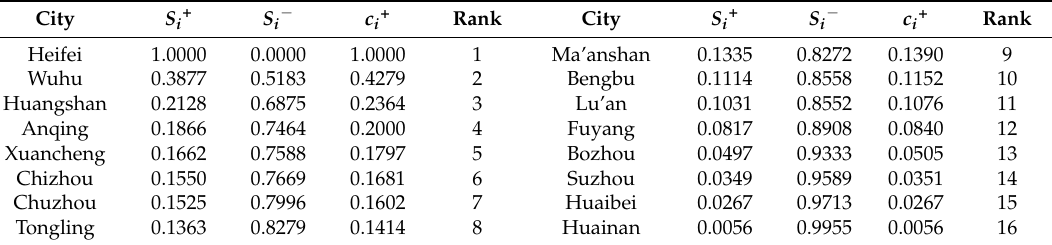
Table 8. The relative closeness and ranking of